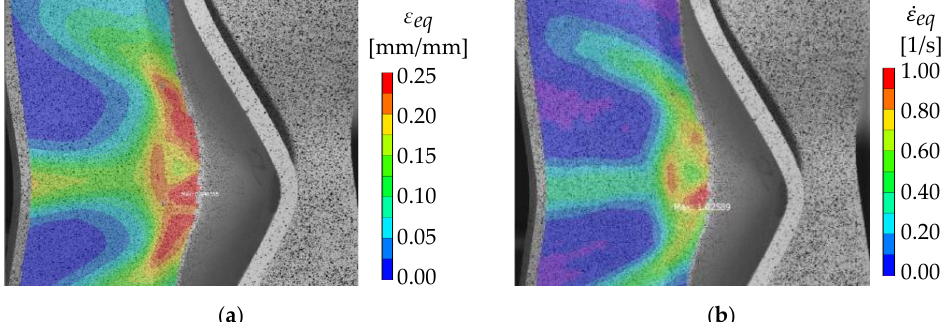
Figure 19. ( a ) Equivalent strain and ( b ) strain rate of a specimen tested at 45 mm/s loading velocity immediately before crack initiation calculated by DIC.